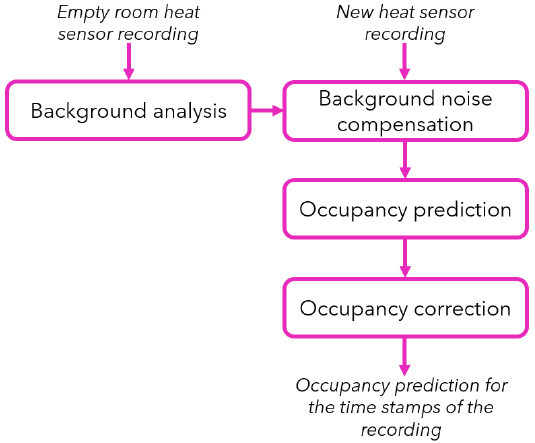
Figure 3. Workflow of the computer vision based occupancy prediction method.